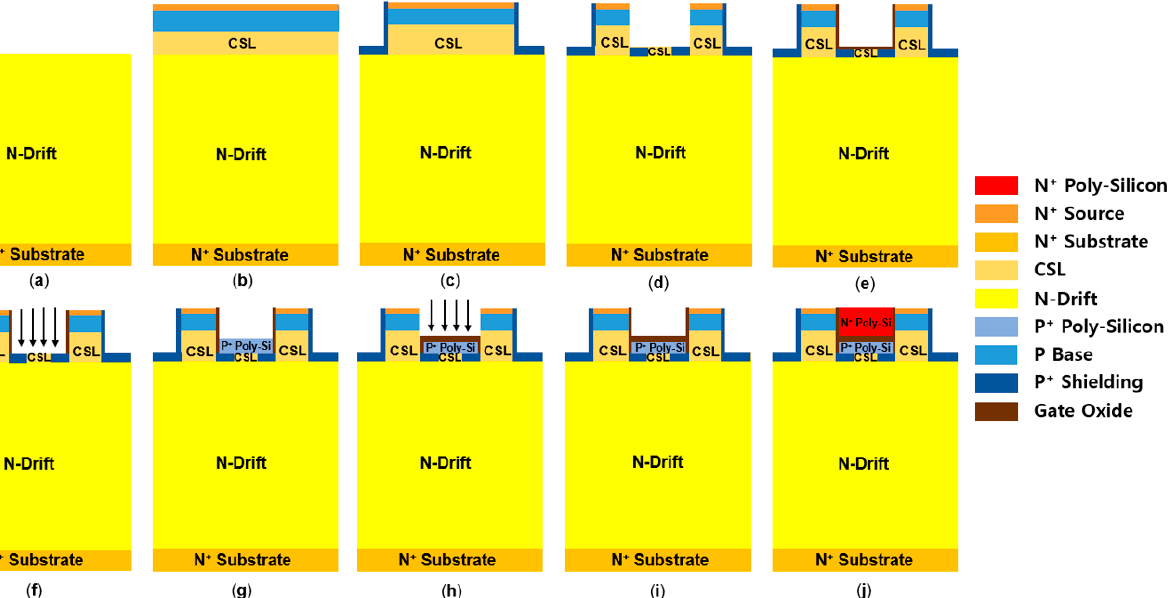
Figure 9. ( a ) HF-FOM of SG-DTMOS with varied L ox and T ox . ( b ) HF-FOM of SHG-DTMOS with varied L ox and T ox . ( c ) Influence of W PS on forward conduction characteristics and breakdown voltage of SHG-DTMOS.